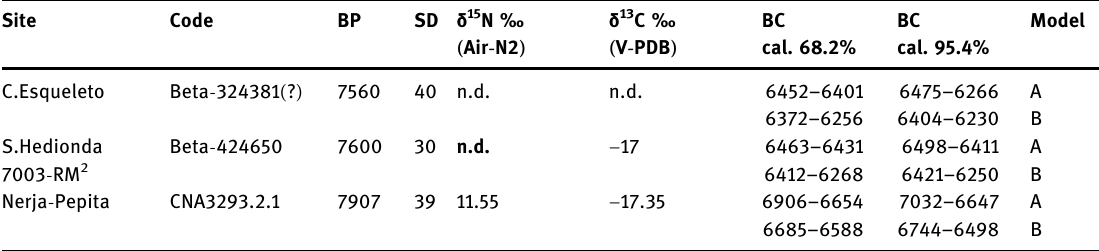
Table 1: Numeric data of the three 14 C datings on Mesolithic human remains in Andalusia using the two calibration models